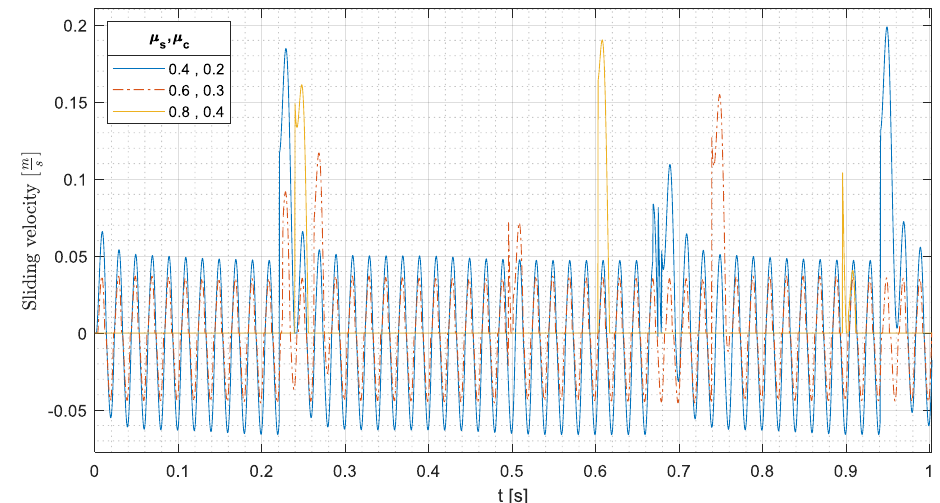
f v = 0.005, and parametric values of static friction coe ffi cients µ c and µ s . Appl. Sci. 2020 , 10 , x FOR PEER REVIEW 0.005 , and parametric values of static friction coefficients 𝜇 𝑐 and 𝜇 𝑠 .